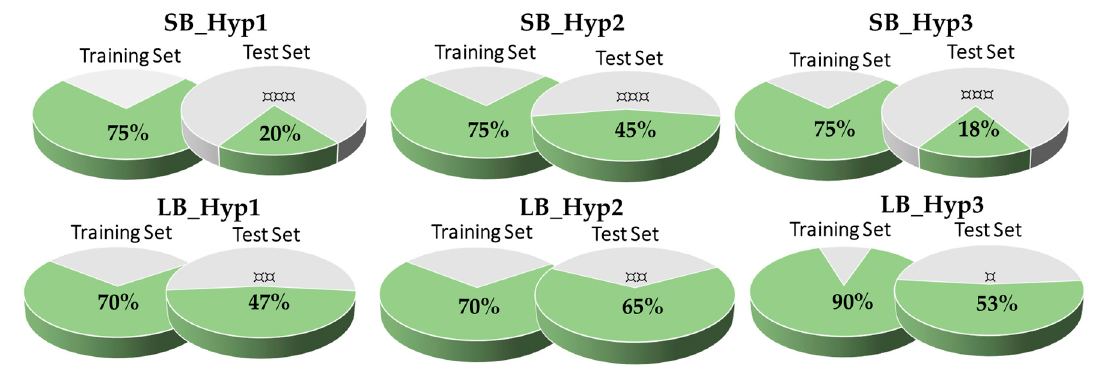
Figure 4. Pharmacophore model validation based on the hit’s detection on Training Set and Test Set. The pie charts show the percentage of retrieved BACE1 inhibitors. Dark grey color denotes relative correct classifications. The models that fit high actives with a lower root-mean-square deviation (RMSD) score (best fitness) and moderate actives with higher RMSD (worse fitness) are signaled by “¤¤¤”; the models that fit more high actives than moderate actives, are signaled by “¤¤”; the models that fit moderate actives with lower RMSD than the high active’s RMSD are signaled by “¤”.